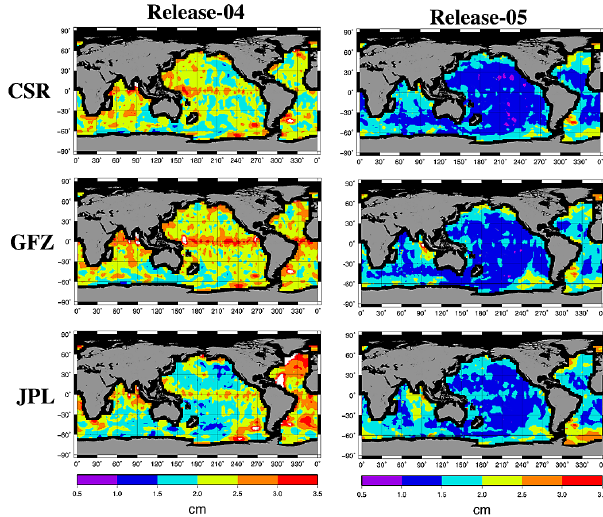
Fig. 3. Standard deviation of differences between unsmoothed OBP from JPL ECCO and GRACE mapped OBP (destriped, 300km Gaussian) for Release-04 (left column) and Release-05 (right col- umn), using coefficients processed by CSR (top), GFZ (middle), and JPL (bottom).